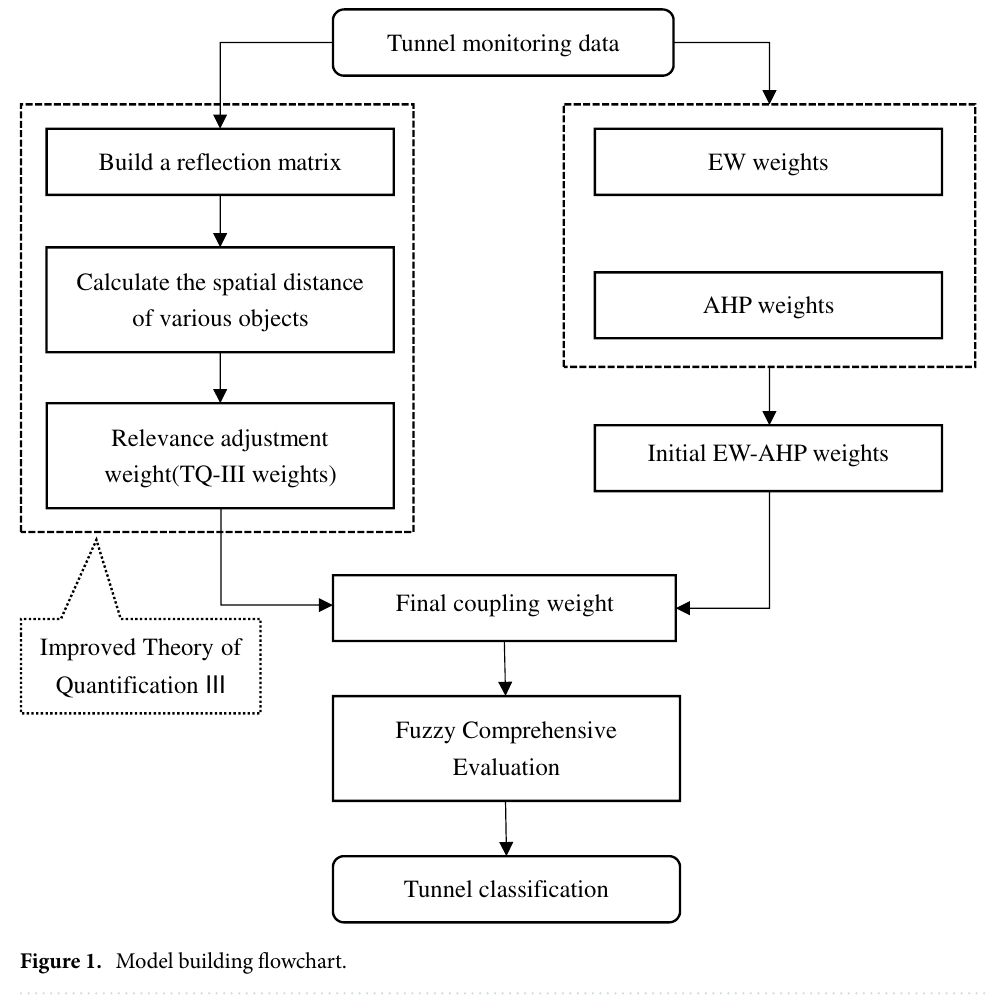
Figure 1. Model building